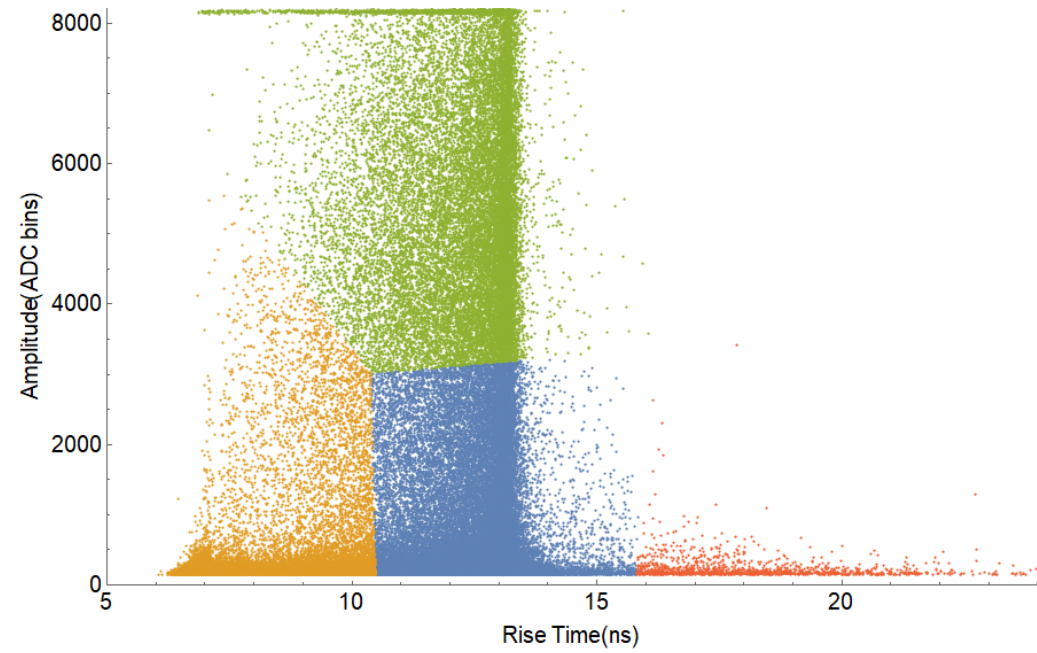
Figure 3. K -means (4) cluster analysis for boundaries selection. Orange: electrons, green: high amplitude muons and electrical discharges, blue: low amplitude muons, red: other type of signals.